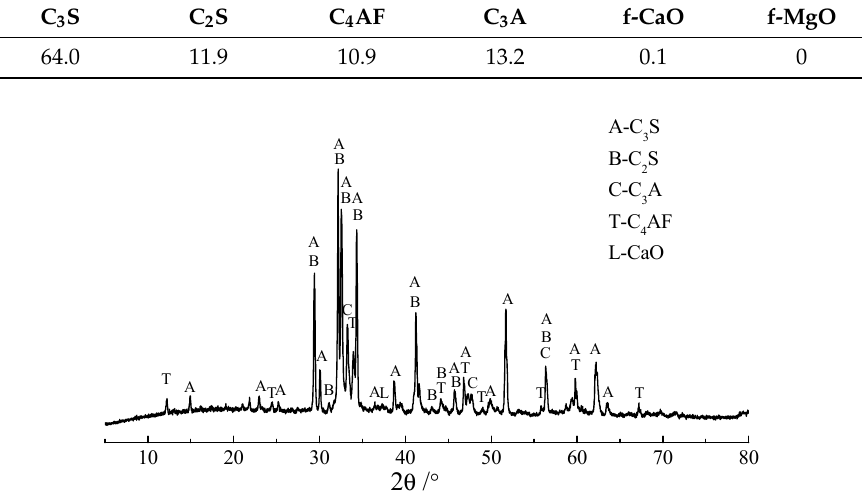
Table 3. Content of minerals in self-made cement clinker (%).